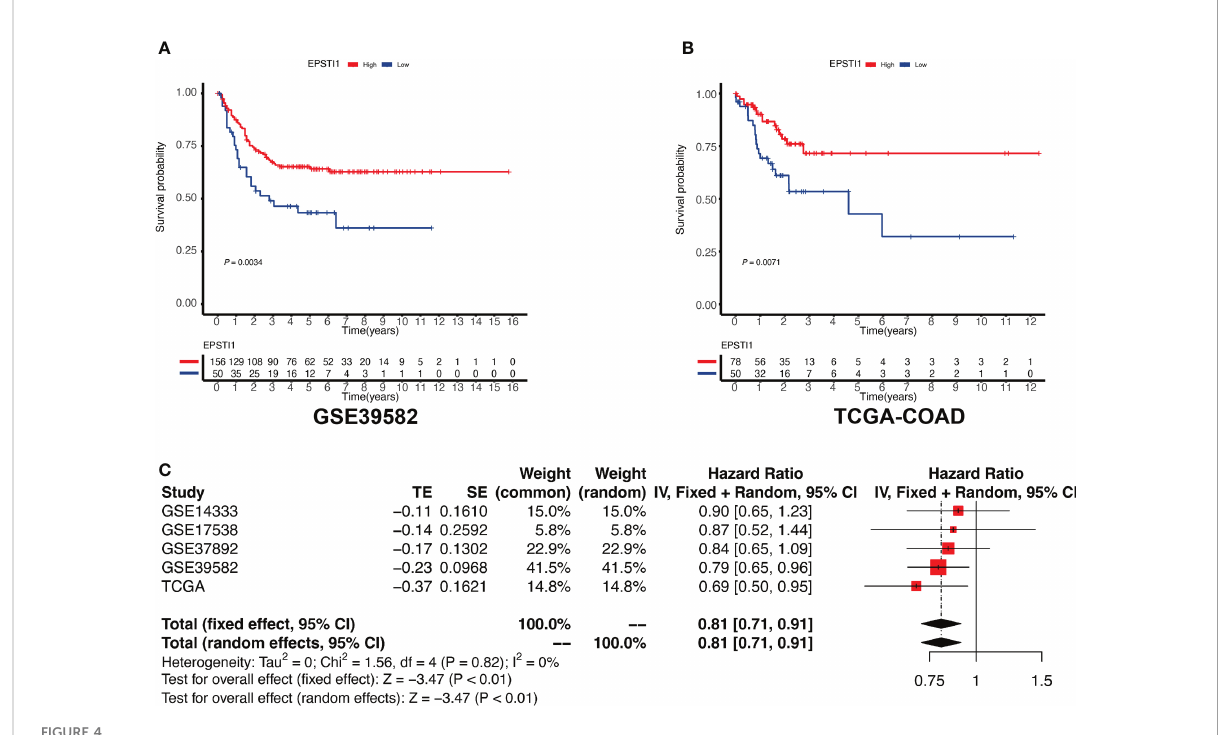
FIGURE 4 Association between EPSTI1 expression level and RFS in patients with stage III CC. CC, colon cancer; RFS, relapse-free survival. (A, B) Kaplan- Meier survival curves for high and low EPSTI1 groups in the GSE39582 and TCGA-COAD cohorts. Patients with high EPSTI1 levels have signi fi cantly better RFS than those with low EPSTI1 levels. (C) A meta-analysis of 5 independent studies shows that the expression level of EPSTI1 is a protective factor for RFS ( fi xed model effect, pooled HR = 0.81, 95% CI 0.71-0.91). HR, hazard ratio; CI, con fi dence